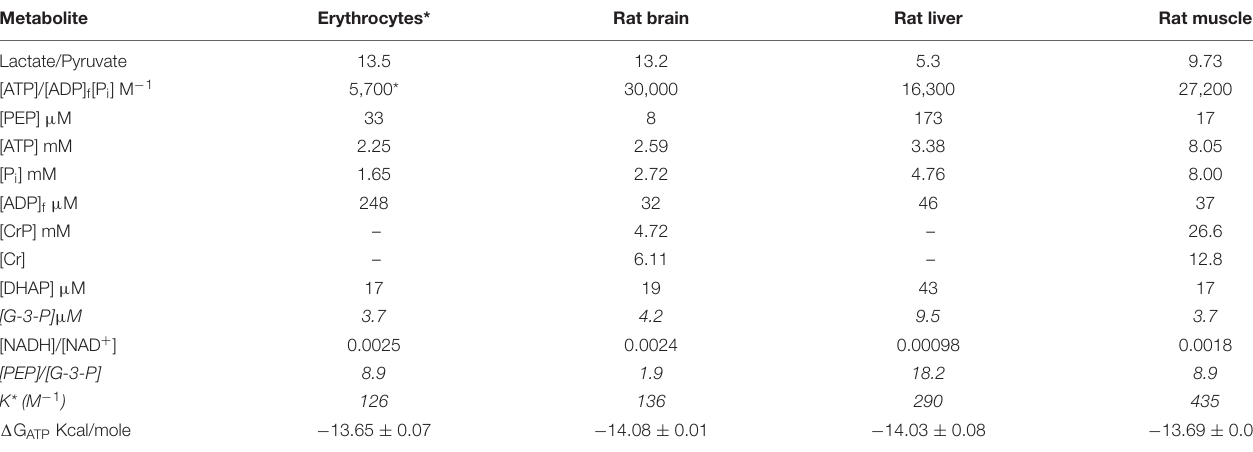
TABLE 1 | Metabolites relevant to the metabolism of glyceraldehyde-3-phosphate to pyruvate in tissues from rats (Veech et al., 1979). Metabolite Erythrocytes* Rat brain Rat liver Rat muscle Lactate/Pyruvate